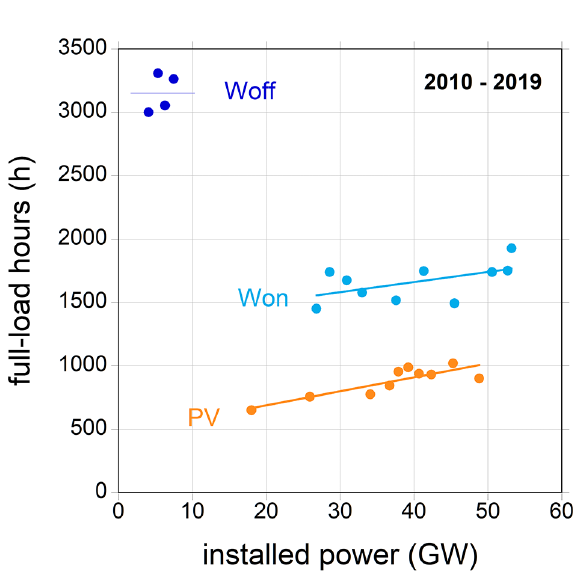
Fig. 9. – The full-load-hours (flh) are plotted for the three renewable energy forms onshore-, and offshore wind and photovoltaic power (PV) vs. the respective installed power. The last ten years are shown for onshore wind (Won) and PV; the last 4 years for offshore wind (Woff). The lines are fits in case of Won and PV and the average level in case of Woff. Data from ENTSO-E and the German grid